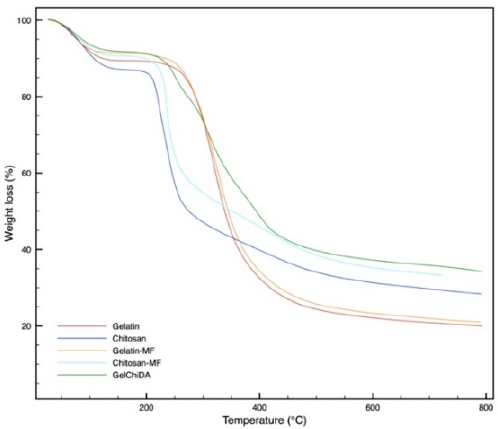
Figure 5. TGA curves of functionalized and unfunctionalized gelatin and chitosan and gelatin- chitosan cross-linked hydrogel. Table 3. TGA analysis of the starting and functionalized polymers and the hydrogel.